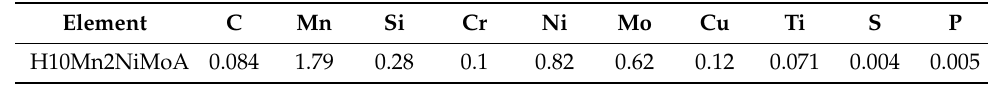
Table 3. The main composition of the welding wire (mass fraction %). Element